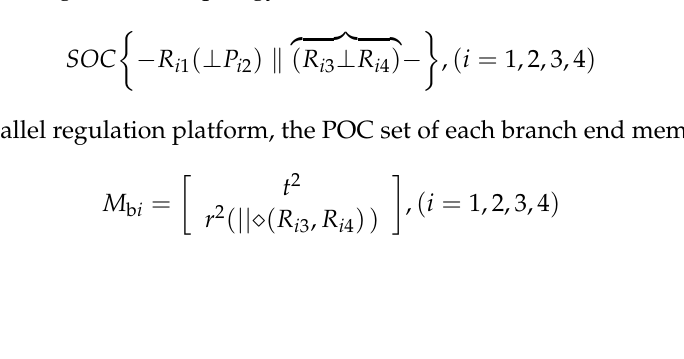
Figure 3. 4-RPU parallel topology schematic diagram.